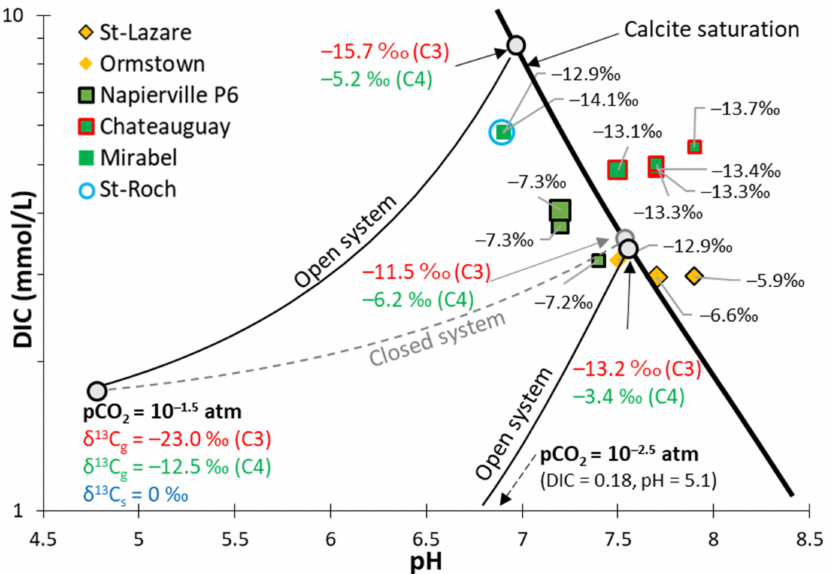
Figure 14. (Modified from Clark & Fritz [33]): δ 13 C DIC , DIC and pH of the samples represented with δ 13 C endmembers, for open and closed system conditions towards soil CO 2 , C3 and C4 vegetation δ 13 C g and different soil pCO δ 13 C ε CO 2 . For an open system, DIC fractionation ( 2 /DIC) at calcite satu- ration is considered between soil CO 2 and weighted contribution of each DIC species, and calculated at 8.5 ◦ C. For closed system, a dilution of δ 13 C g by half of δ 13 C s from carbonates is